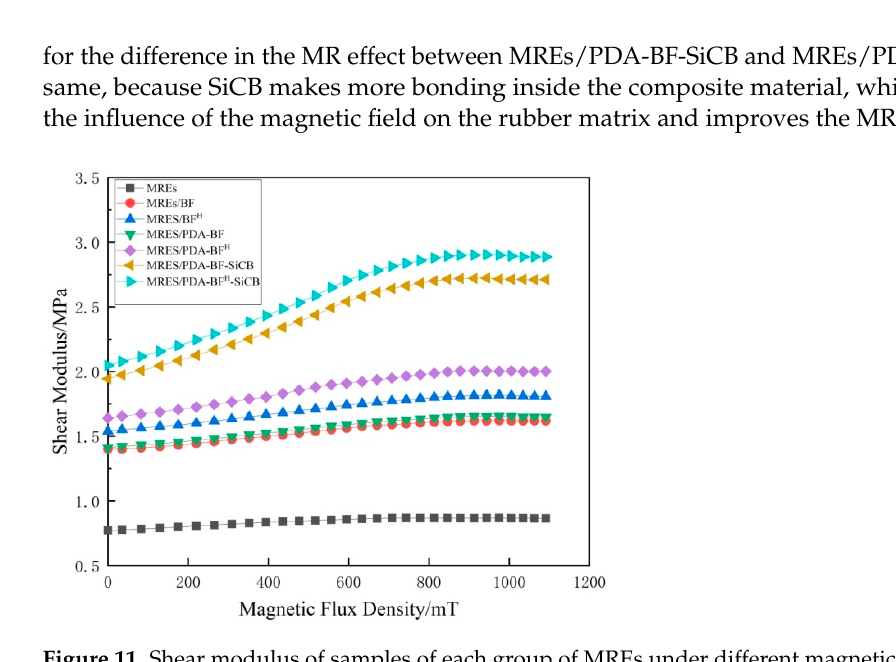
Figure 11. Shear modulus of samples of each group of MREs under different magnetic flux density.